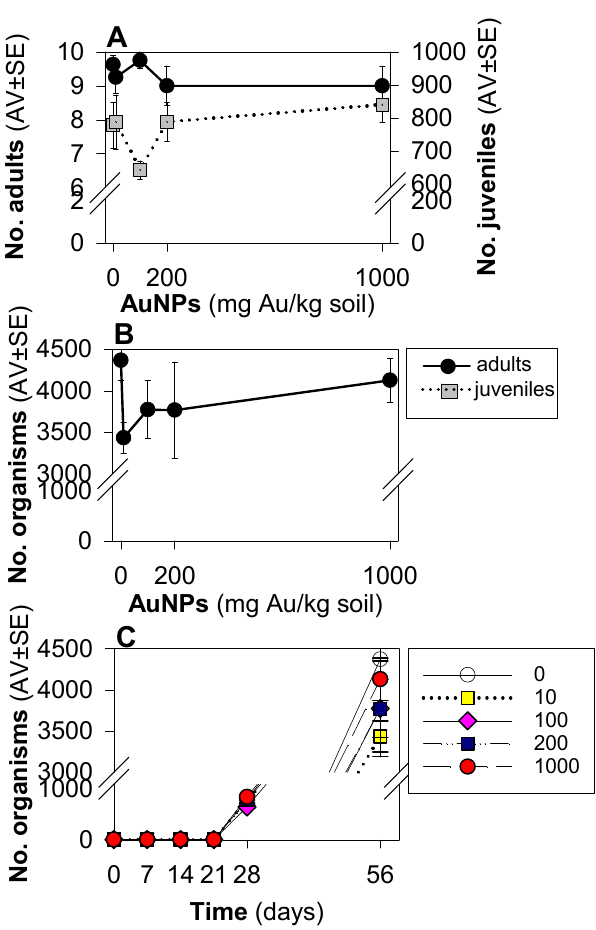
Figure 1. Results of the reproduction test with Enchytraeus crypticus when exposed in LUFA 2.2 soil to gold nanoparticles (AuNPs), over 56 days, in terms of number of adults and juveniles at day 28 ( A ), total number of organisms at day 56 ( B ), and in terms of total number of organisms at days 0, 7, 14, 21, 28 and 56 of exposure ( C ). Values are expressed as average ± standard error (AV ± SE).